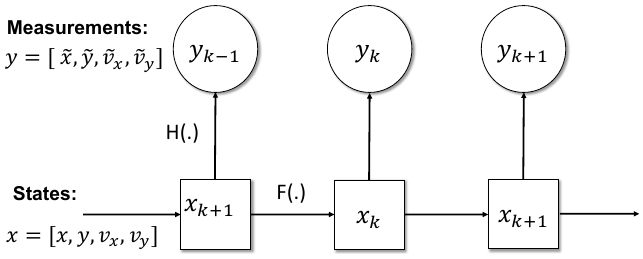
Figure 4. Markovian dependencies for the tracking